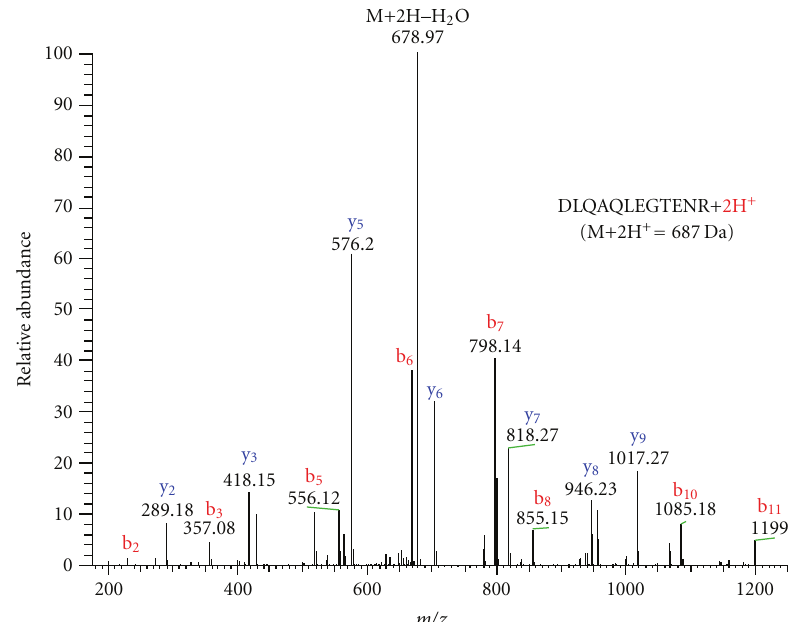
Figure 3: Fragmentation pattern of the doubly charged peptide DLQAQLEGTENR (residues 135 to146) from the protein LemA. This peptide covers 5.6% of the protein sequence and 5 additional unique peptides of this protein were found in the extra cellular fraction of B. vietnamiensis G4.